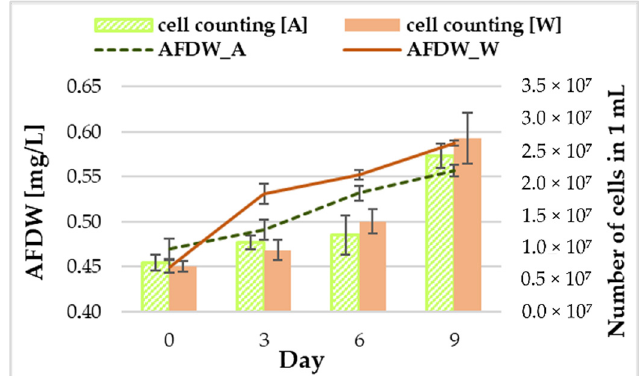
Figure 2. Comparison between Ash Free Dry Weight (AFDW) and cellular concentration evaluated via cell counting. Results are reported as means ± standard deviation ( n = 9).